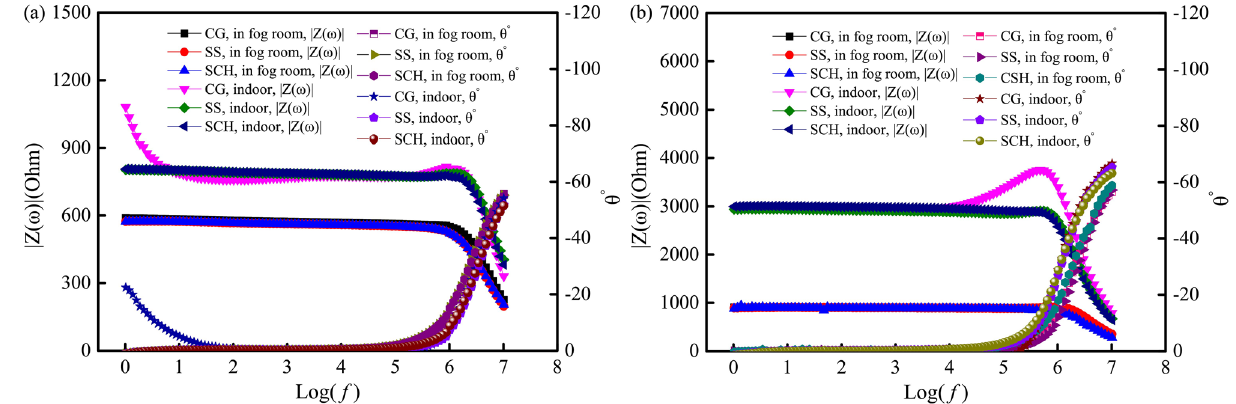
Figure 8. Bode plots of the four-point measurement with different conductive media between the current electrodes and the sample. ( a ) 3d curing ages; ( b ) 28d curing ages.